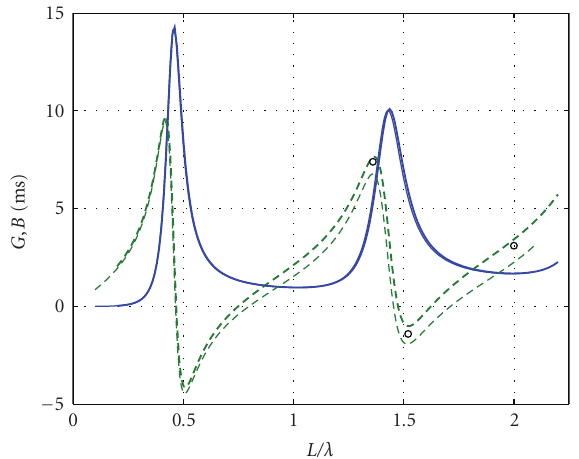
Figure 7: Comparison between admittances obtained with the proposed code (thick lines) and those obtained with NEC2 (thin lines). Solid lines: conductance G . Dashed lines: susceptance B . Circles: MoM data from Figure 4 . 5 of [15].